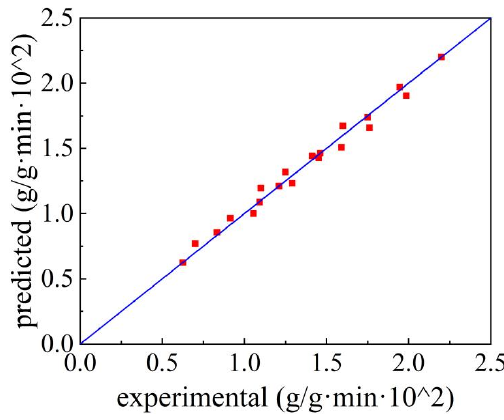
Figure 7. Comparison of the average drying rate predicted and experimental.